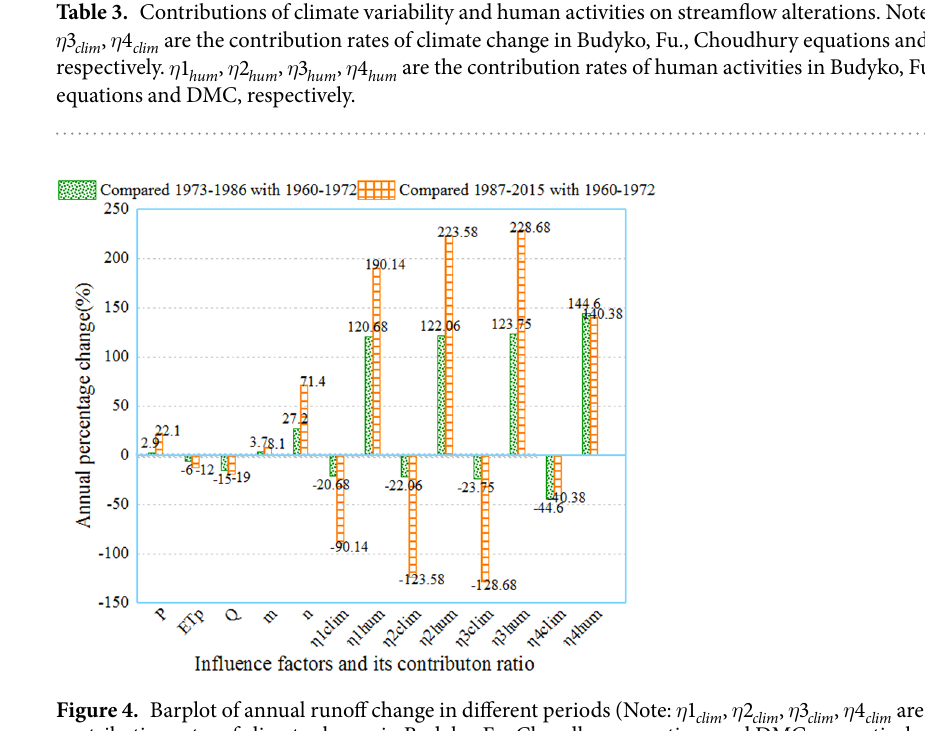
, η 2 , η 3 , η 4 are the clim clim clim clim , η 2 , hum hum